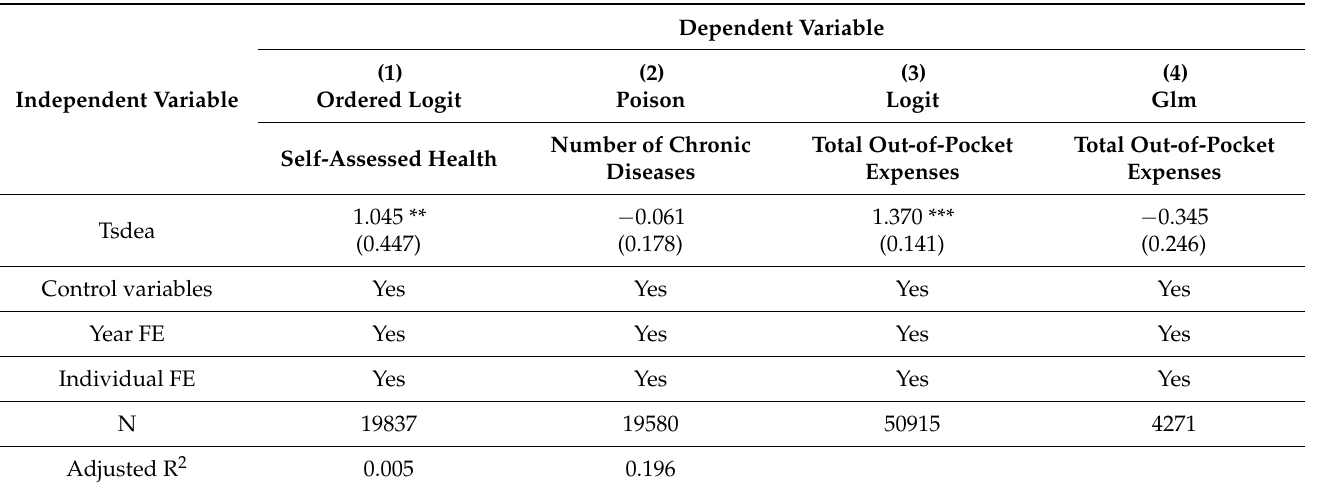
Table 5. Empirical results of the impact of fiscal health expenditure efficiency on resident health in